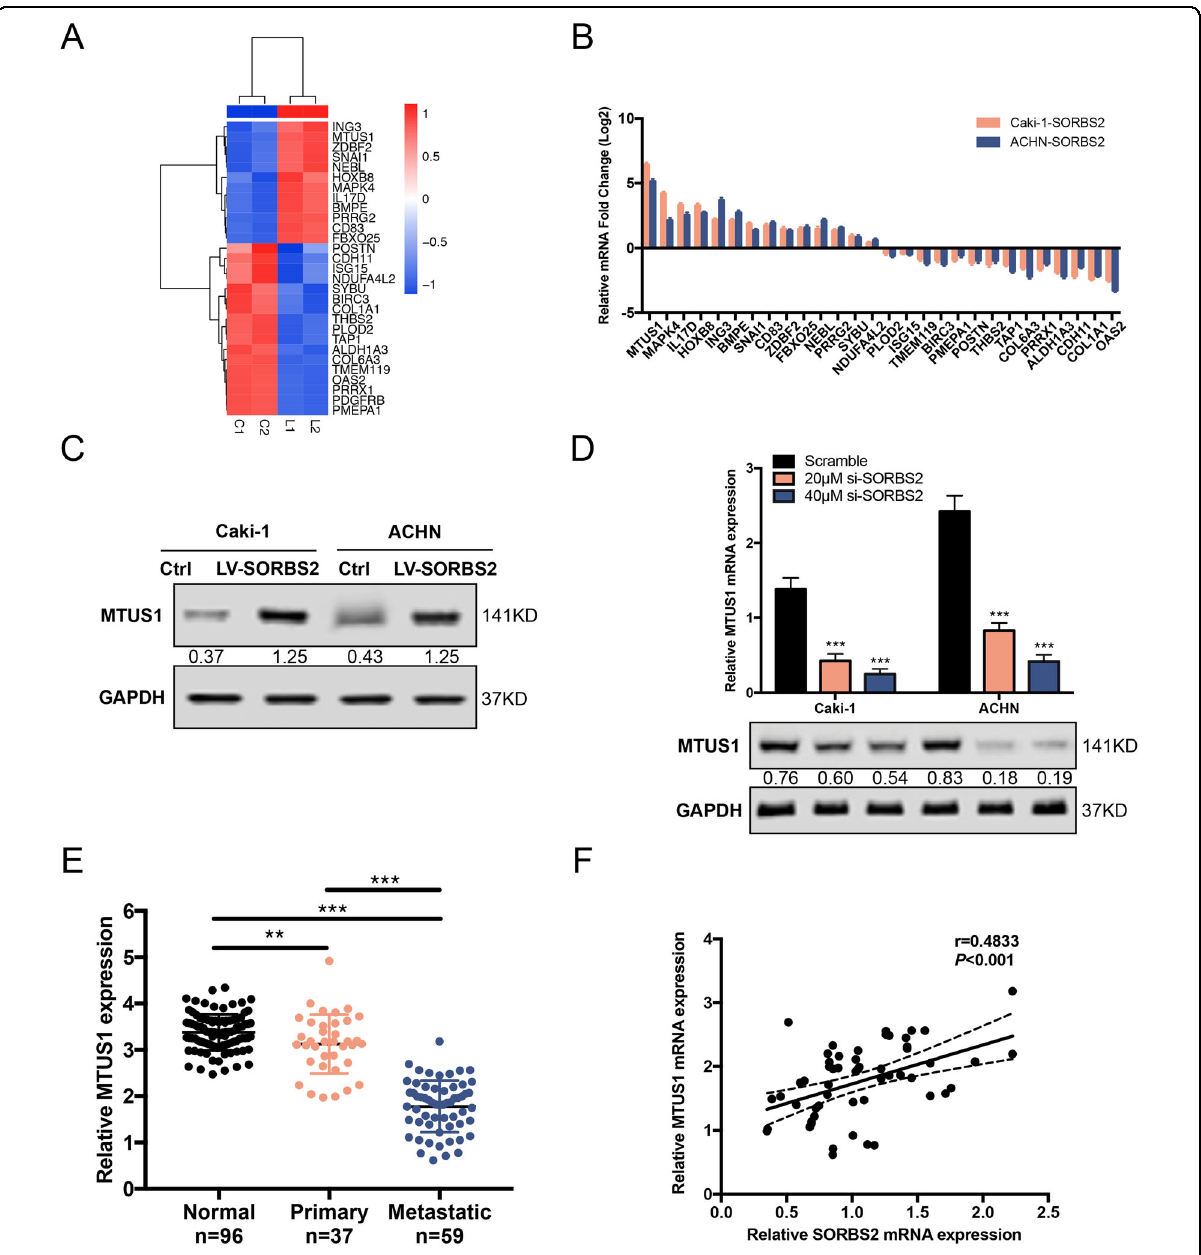
Fig. 3 SORBS2 upregulated MTUS1 expression. A RIP-sequencing of potential SORBS2-bound genes. B qRT-PCR validation of potential SORBS2- bound genes. C Western blot analysis of MTUS1 expression in SORBS2-overexpression and control cell lines. D Knockdown of SORBS2 led to MTUS1 downregulation. E qRT-PCR analysis of MTUS1 expression in ccRCC tissues. F Spearman correlation analysis of SORBS2 and MTUS1. ** P < 0.01; *** P <